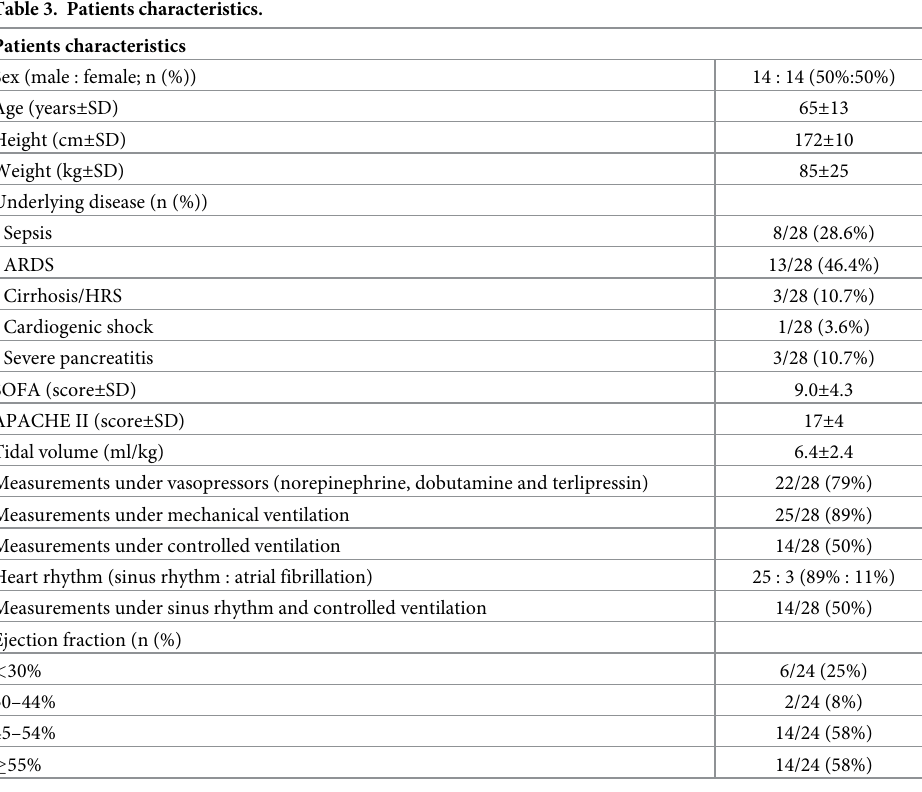
Table 3. Patients characteristics. Patients